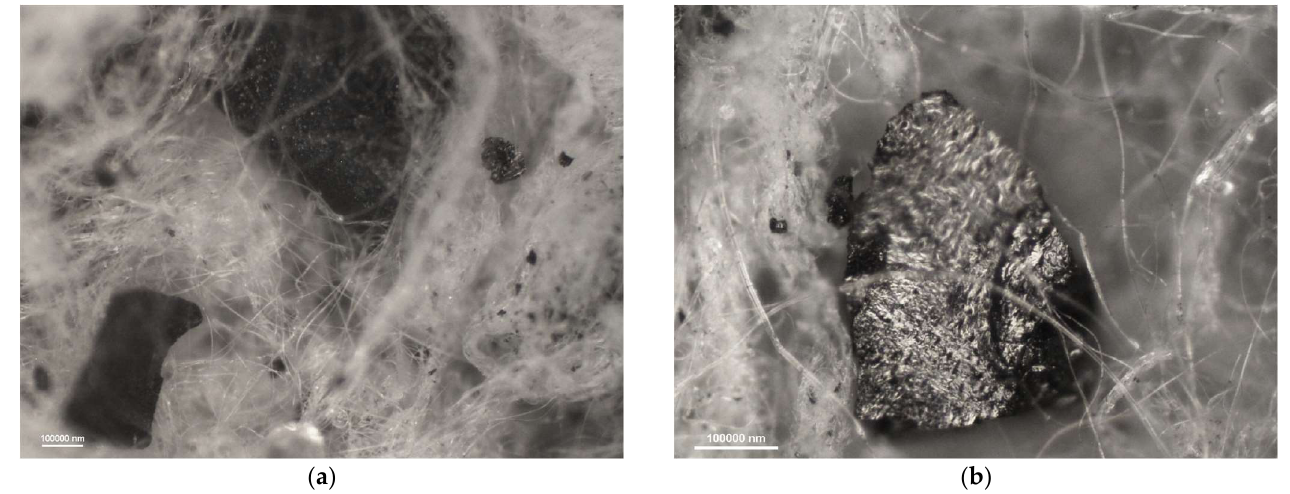
Figure 6. Photomicrographs of adsorbing nonwoven from half-mask 1 at a magnification of ( a ) ×50 and ( b ) ×100 .